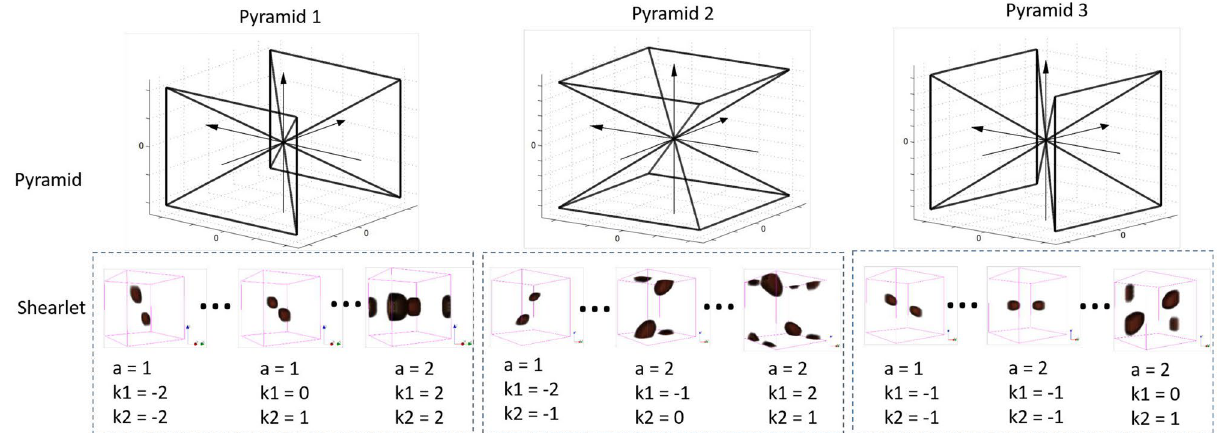
Figure 4. The pyramids for 3D shearlet decomposition, and some shearlet examples with corresponding parameters of scales and shears are shown in the figure. The parameter a denotes the scale of the corresponding shearlet filter while the shear parameter k 1 , k 2 controls the